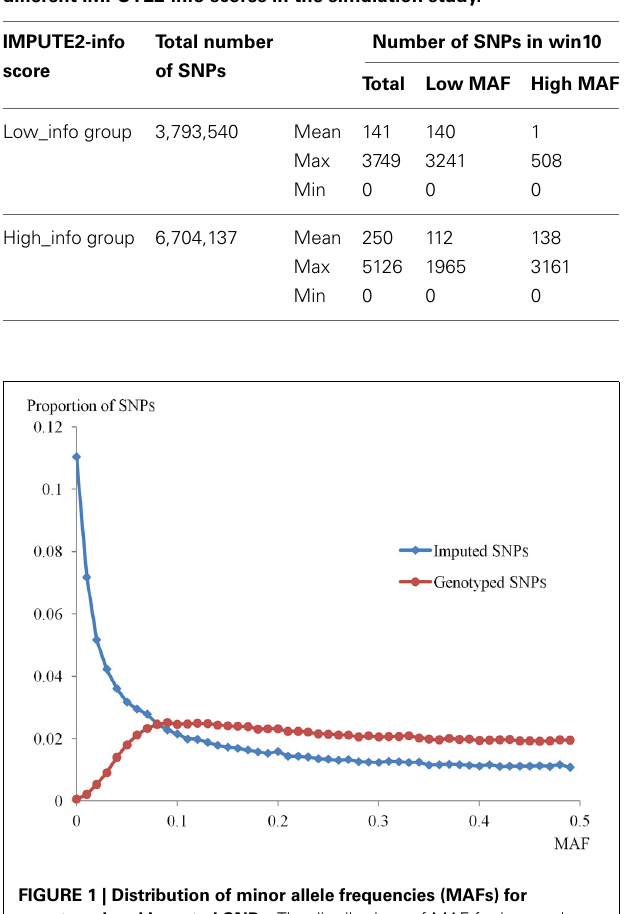
FIGURE 1 | Distribution of minor allele frequencies (MAFs) for genotyped and imputed SNPs. The distributions of MAF for imputed SNPs within the high_info group and for genotyped SNPs in this population are shown. The x-axis indicates the MAF of both groups of SNPs. The y-axis represents the proportion of SNPs in each MAF